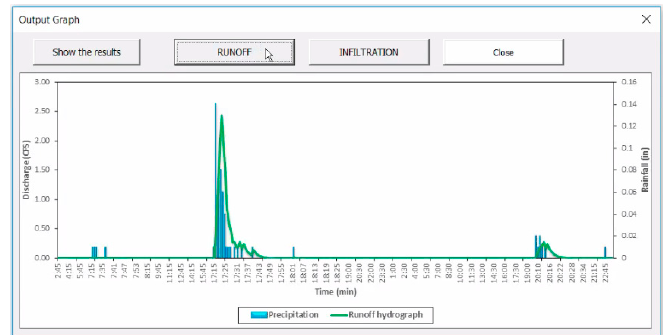
Figure A8. Displaying runoff hydrograph